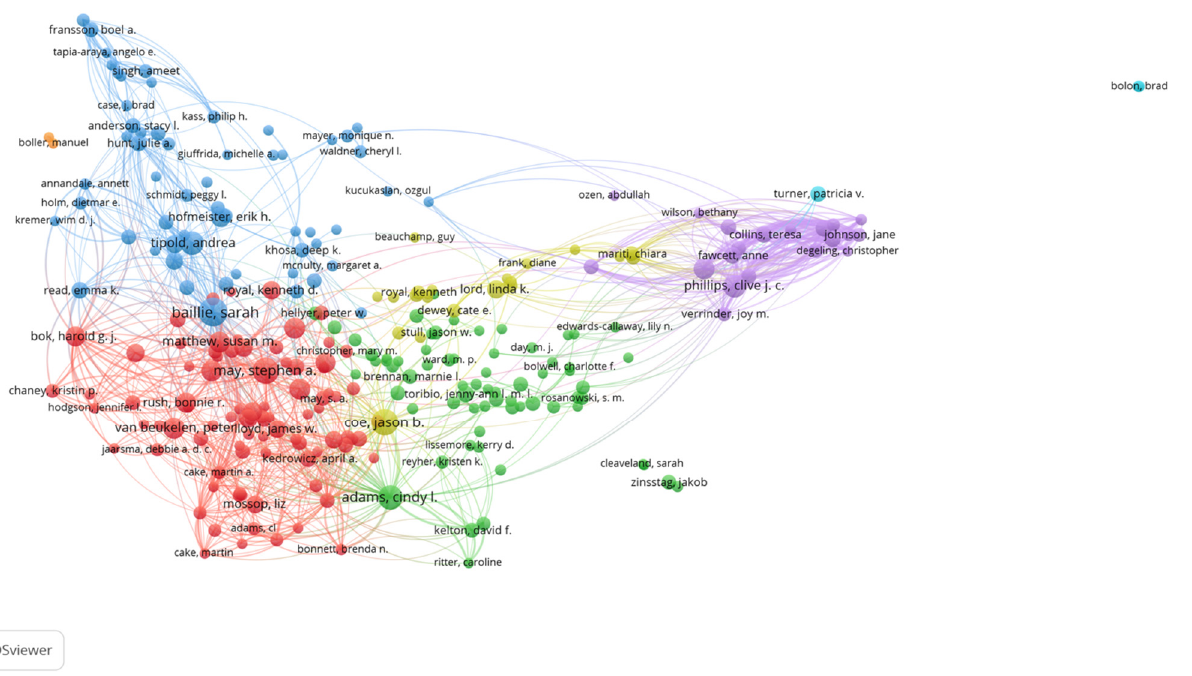
Figure 6. Author collaboration analysis of 6006 veterinary education publications (VEPs) from 2000 to 2021.